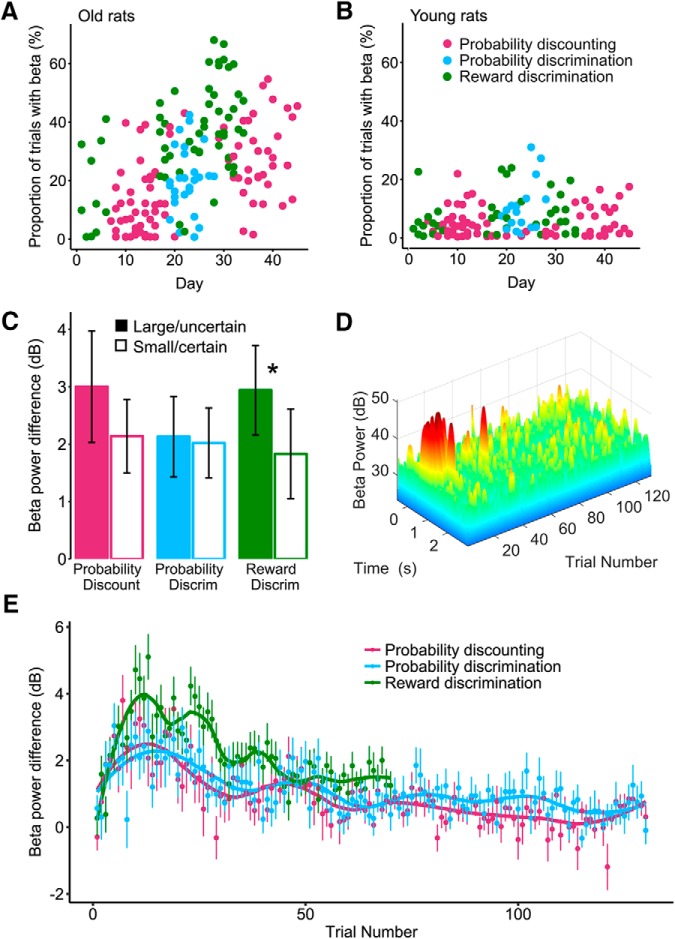
Incidence of high-power β epochs increases with training days but decreases within session trials. A, The proportion of trials with task-evoked β oscillations increases across daily sessions in old rats. Colors represent the task performed: magenta, probability discounting; green, reward discrimination; blue, probability discrimination. B, Same scatterplot as in A, showing that β power did not increase over days in the young rats, and was, overall, lower than for the older animals. C, β power is greater following presses for the large reward in the reward magnitude discrimination task in aged rats (data taken from block 1 in the late training period, where β is highest). Star denotes significance (p < 0.05). D, Example distribution of β power over trials in a daily session of a probability discounting task illustrating the greater amount of β power events early in the task, in an old rat. The time axis is aligned at 0 for the lever press. Warmer colors correspond to higher β power. E, β power as a function of trial, separated by task type (data taken from the late training period, where β is highest). Overall, β power was higher in the reward magnitude discrimination task (green). Within a session, β power is highest around trial 10 and then gradually decreases thereafter.